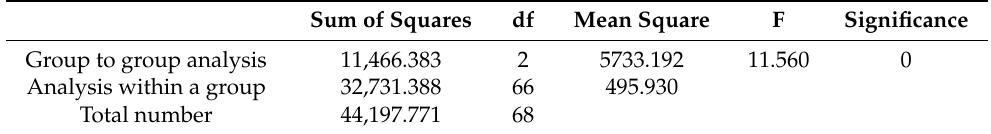
Table 3. One-way ANOVA.